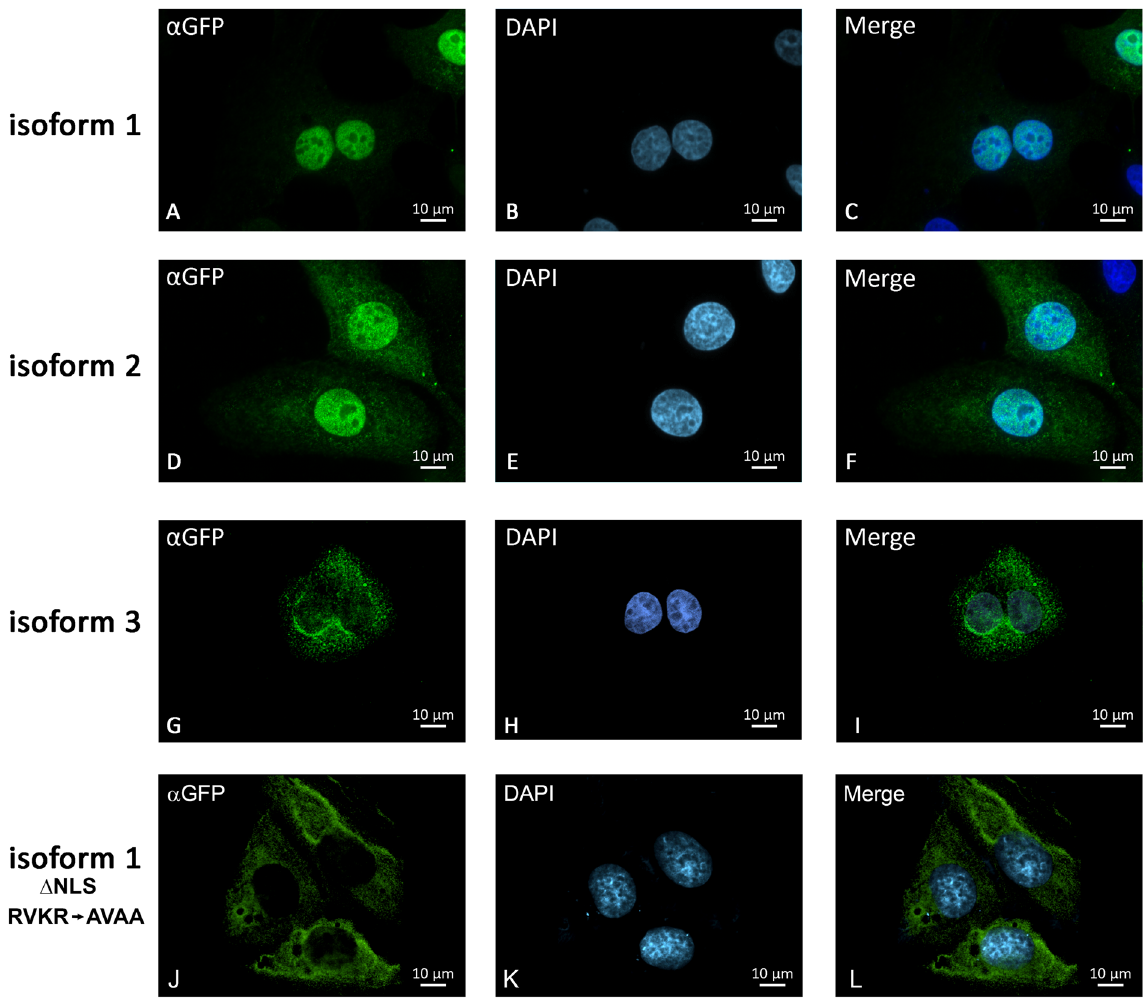
an antibody to GFP (panels A, D and G), and the nuclei were stained with DAPI (panels B, E and H). NudCD1 Isoform 1 shows a strictly nuclear accumulation ( A ), NudCD1 isoform 2 shows both a cytoplasmic and nuclear ( D ) and a predominantly cytoplasmic accumulation is shown for NudCD1 isoform 3 ( G ). Cells transfected with a NudCD1 Isoform 1 with a mutated NLS (RVKR to AVAA) were labelled with an antibody to GFP ( J ), and the nuclei were stained with DAPI ( K